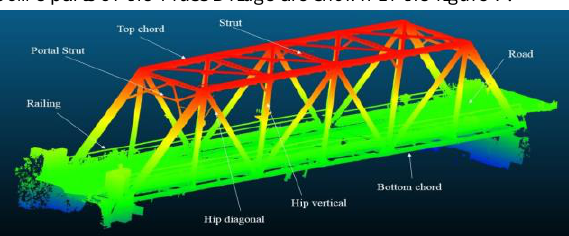
Figure 7: Parts of Truss